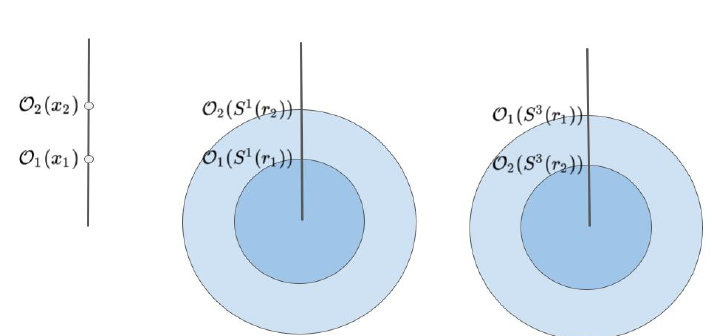
Figure 4: From left to right, 1d TQM, 2d VOA, and 4d VOA operators, depicted by the circles. The thick straight lines are the transverse directions of the operators, showing the codimension-1 nature of the algebra of operators in each